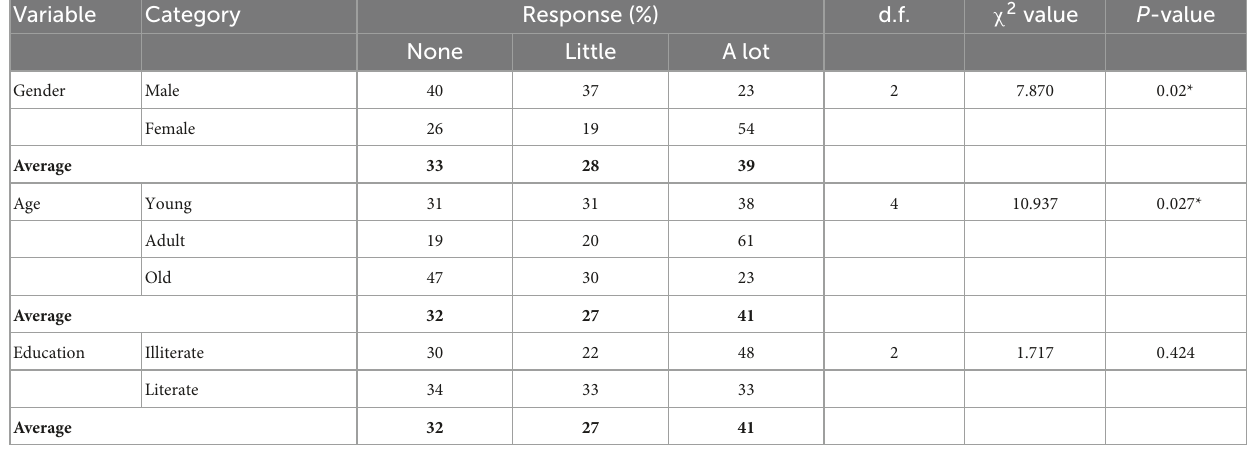
d.f.representsdegreesoffreedom. *Statisticallysignificantdifference.